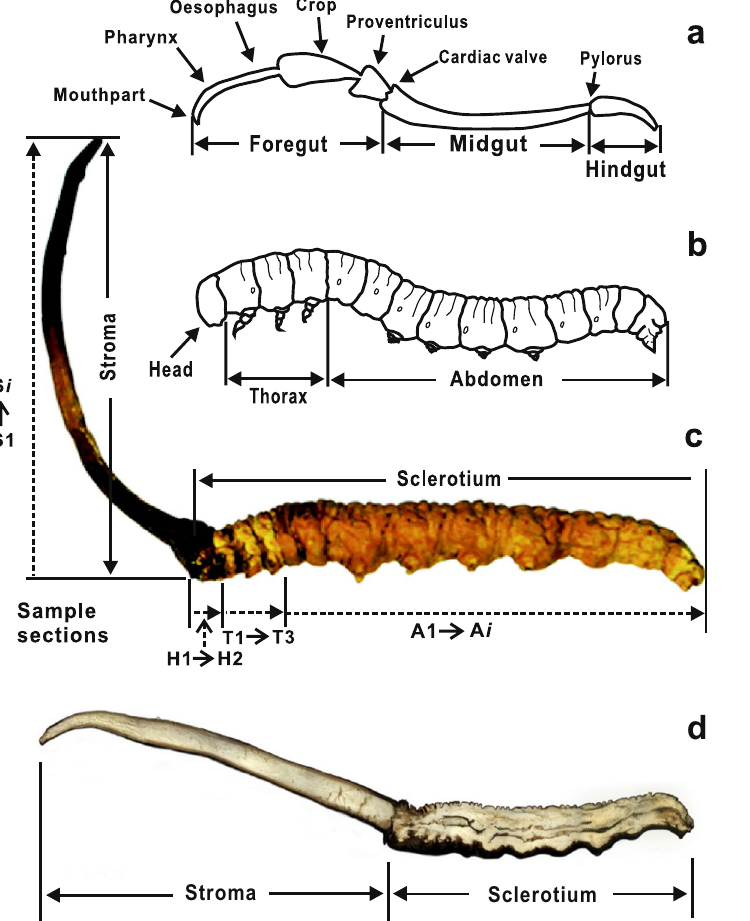
Figure 4. Schematic diagram illustrating the digestive tract ( a ), host larva ( b ), Cordyceps sinensis ( c ), and the inner structure of Cordyceps sinensis ( d ). The diagram was created using CorelDraw X4 (Corel Corporation, Ontario,